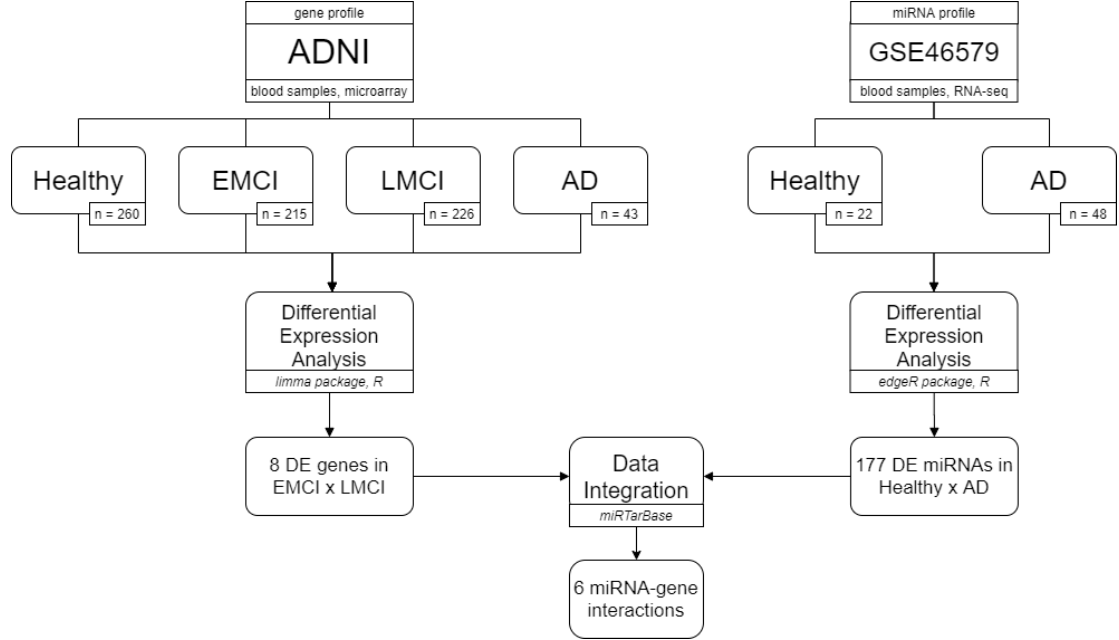
Figure 1. Overview of experimental data, statistical analysis, databases, differential expression analysis (DEA) results, and data